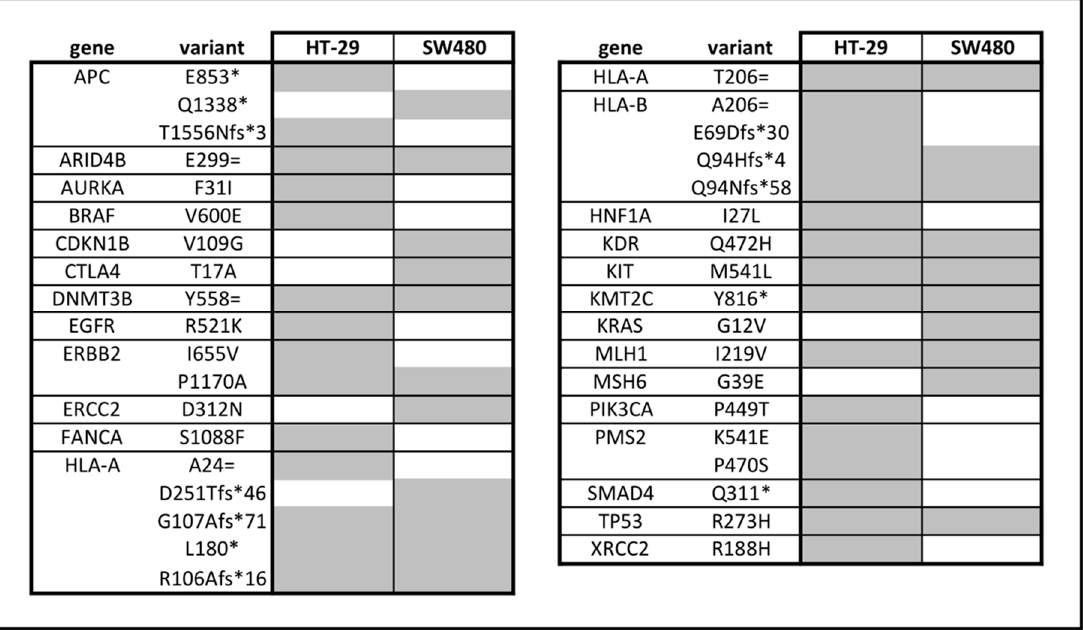
Figure 6. Fragment–length distribution of cell-free DNA isolated from the media of HT-29 and SW480 cells was detected with BioAnalyzer. Electropherograms represent a data plot of size in base pairs (bp) versus fluorescence (FU). Average DNA concentrations were measured with Qubit 1.0 fluorometer. Av. conc.: average concentration.